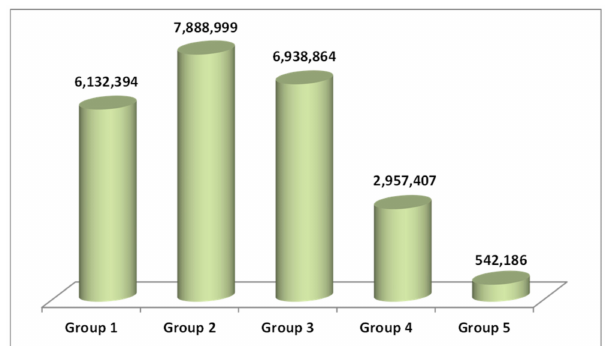
Figure 4. Population of each group of cities.